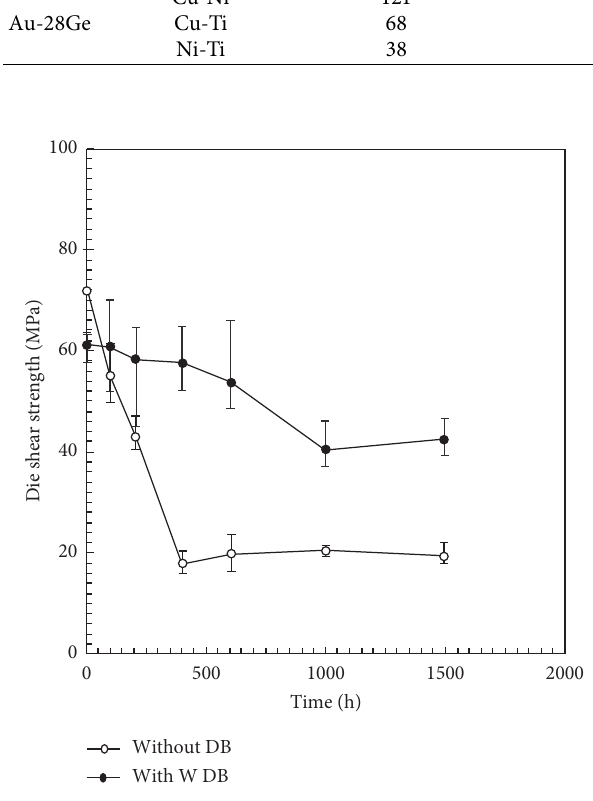
Figure 8: Influence of aging time on the die shear strength of Au- Ge/ENIG solder joint with or without W-DB [48].